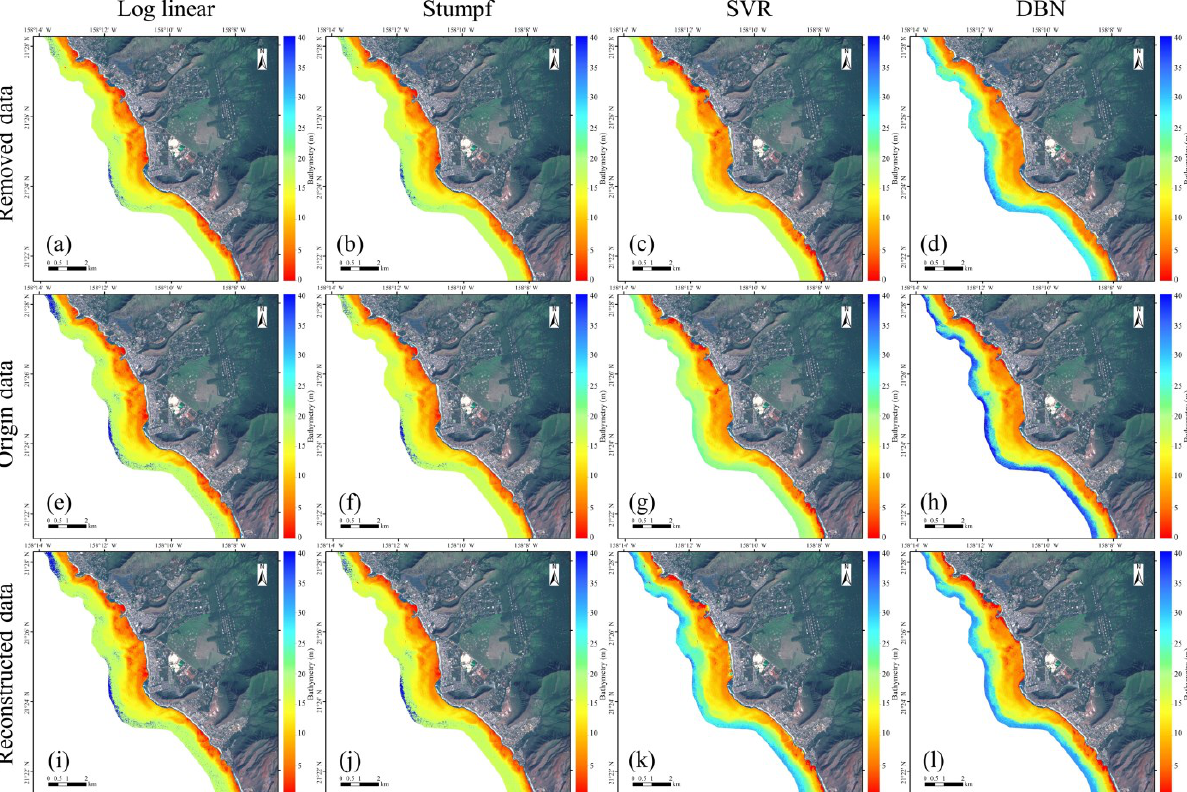
Figure 9. Shallow-water bathymetric maps derived from four models with three groups of data in the Oahu Island study area. ( a – d ) Bathymetric maps derived from four models based on data with manual removal; ( e – h ) Bathymetric maps derived from four models based on origin data; ( i – l ) Bathymetric maps derived from four models based on reconstructed data.